Question: Reading the figure, is the described quantity rising or falling?
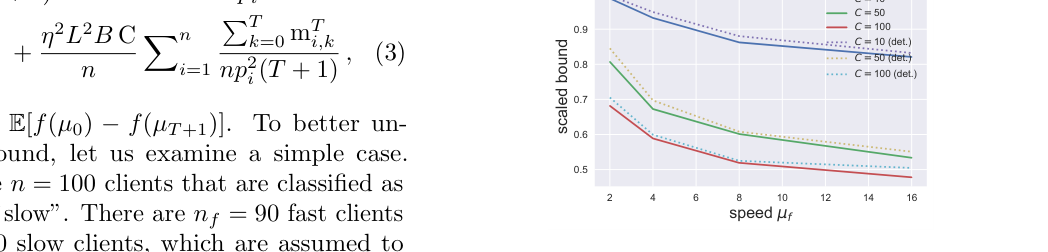
Answer: increasing